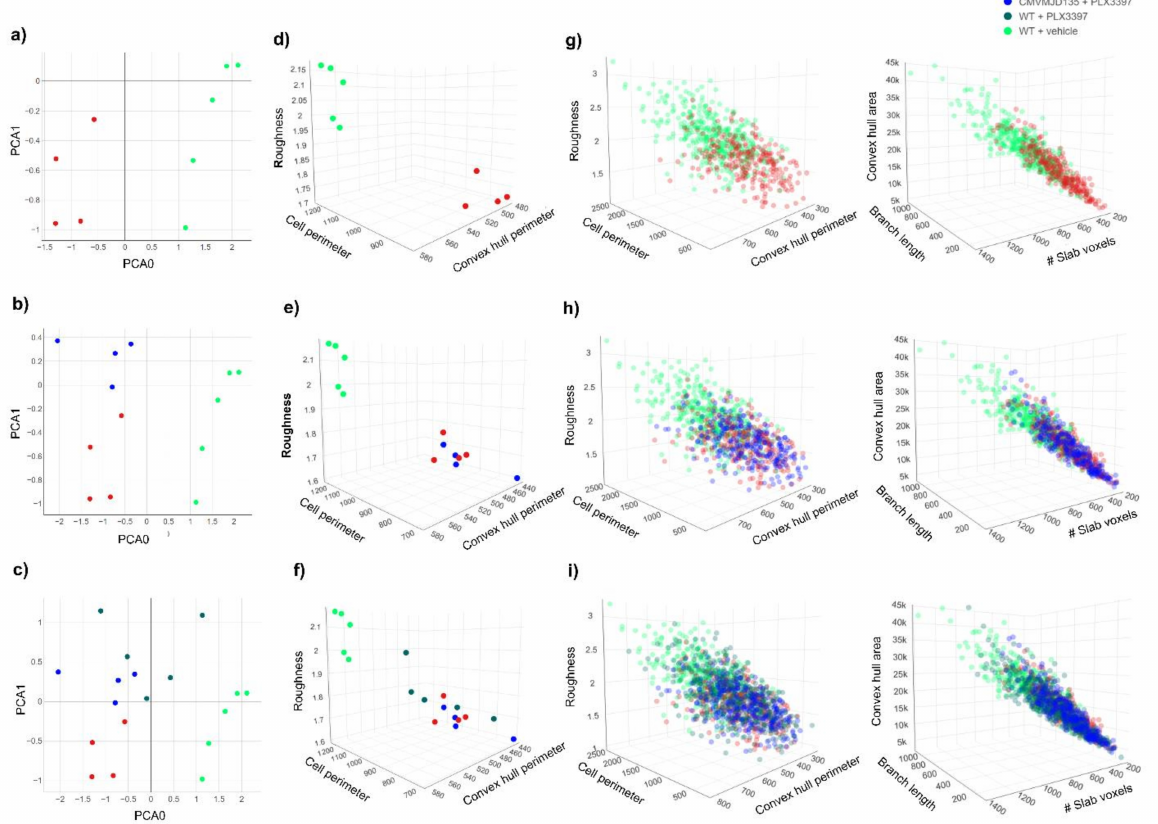
Figure 4. Separation of WT + vehicle group and all the remaining groups, including WT + PLX3397, CMVMJD135 + vehicle, and CMVMJD135 + PLX3397 mice, regarding the 22 significant morphological parameters found in the microglial cells from the DCN. ( a ) 2D scatter plot showing the distribution of WT + vehicle mice (in green) and CMVMJD135 + vehicle (in red) on a principal components plane. ( b , c ) 2D scatter plots showing that the remaining groups (WT + PLX3397 and CMVMJD135 + PLX3397) were plotted closer to CMVMJD135 + vehicle mice, regarding the 22 significant morphological parameters found in the DCN. ( d – f ) 3D scatter plots showing a separation between WT + vehicle mice and the remaining groups regarding their roughness, cell perimeter, and convex hull perimeter. ( g – i ) Data points of a total of 387 microglial cells from WT + vehicle mice, 256 microglial cells from CMVMJD135 + vehicle mice, 475 microglial cells from WT + PLX3397 mice, and 263 microglial